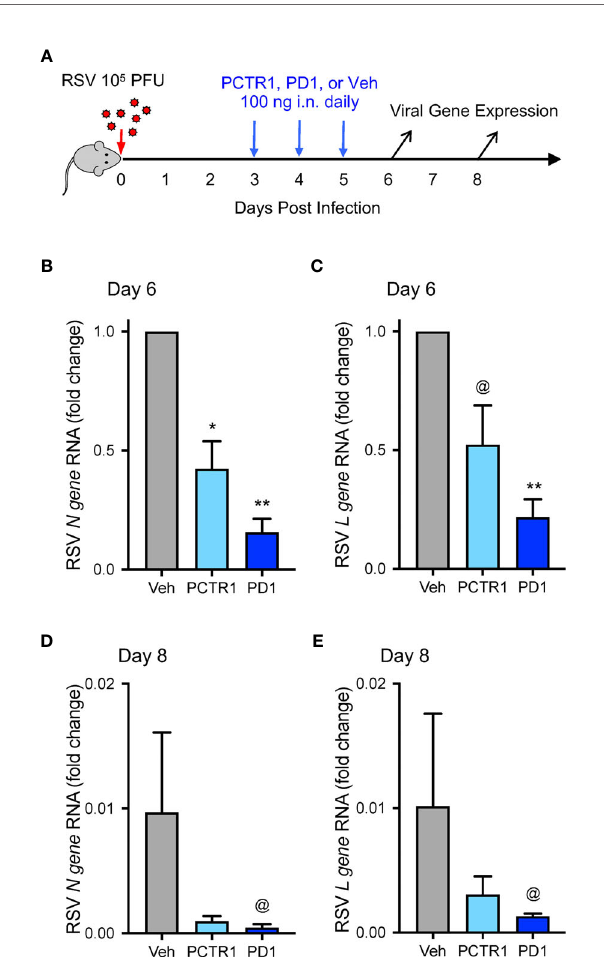
FIGURE 3 | PCTR1 and PD1 decrease viral transcripts during mouse RSV infection. (A) Schema of experimental mouse infection with intranasal 10 5 PFU of RSV, administration of PCTR1 or PD1 (100 ng intranasal) or vehicle daily on days 3-5 post infection, and measurement of viral gene expression on day 6 and day 8. (B – E) Relative RNA expression of (B) RSV N gene or (C) RSV L gene in the mouse lung tissue at day 6 after RSV infection or of (D) RSV N gene or (E) RSV L gene at day 8. Values are mean of n=4-9 per group ± SEM and include >4 separate experiments (B, C) or 1 experiment (D, E) . * p < 0.05, ** p < 0.01, @ p ≤ 0.10 vs vehicle by Kruskall-Wallis test with Dunn ’ s multiple comparison